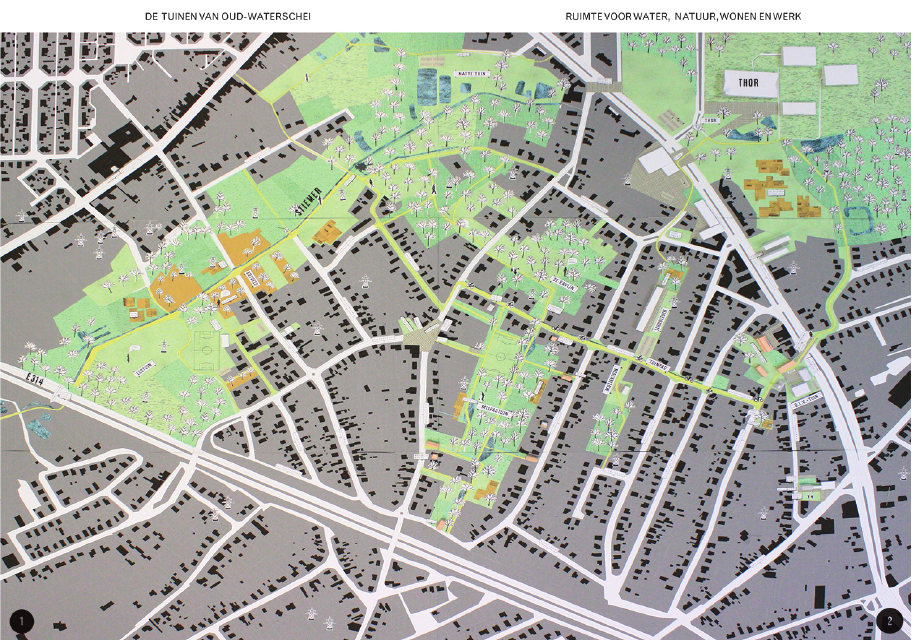
Figure 1. The neighbourhood map on a double page in the first section ‘places’ of the atlas. Source: Anse Arits, Laura Enkels, Julie Polus, Alexander Verlaak, and Barbara Roosen (based on the digital topographic map of Flanders, GRB 2018). ing plots. He imagined a second pedestrian access to the